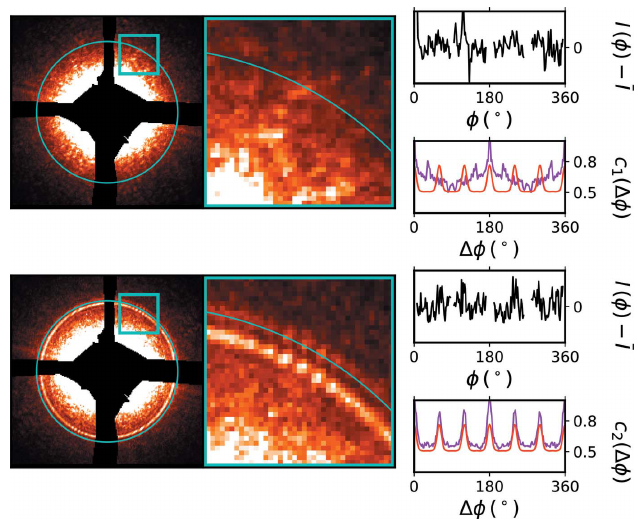
Figure 4 Example of a sample (5 (cid:11) 5 hex array) where the background has been intentionally increased (using the diffuse scattering of 3 (cid:11) 75 m m of polyimide material). The top row shows data for the sample alone. The sample’s scattering peaks (which should appear along the cyan circle) are not discernible (the blue square shows a zoomed-in region). The intensity along this azimuthal arc (black curve, right) similarly shows no hint of the sample peaks. Performing a correlation analysis (magenta curve) does not recover the sample symmetry (which should match the model curve, shown in red). The bottom row shows an equivalent sample in the presence of an amplifier. Although the sample peaks still cannot be seen, distinct interference fringes are clearly visible. The angular intensity (black curve) can be analyzed to extract the second-order correlation function (magenta), which closely matches the expected sample symmetry (red). Thus, the interference fringes encode the sample’s structural information. By exploiting interference between the sample and an amplifier, the sample’s structure can be reconstructed, even though the sample by itself cannot be